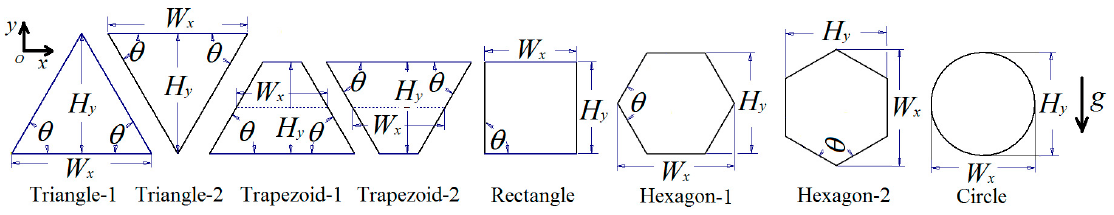
Figure 1. Schematics of the triangular, trapezoidal, rectangular, hexagonal, and circular cells. Table 1. The characteristic angles of different cells with AR = 0.5, 0.866, 1.0, and 1.2. Cells AR = 0.5 AR = 1.0